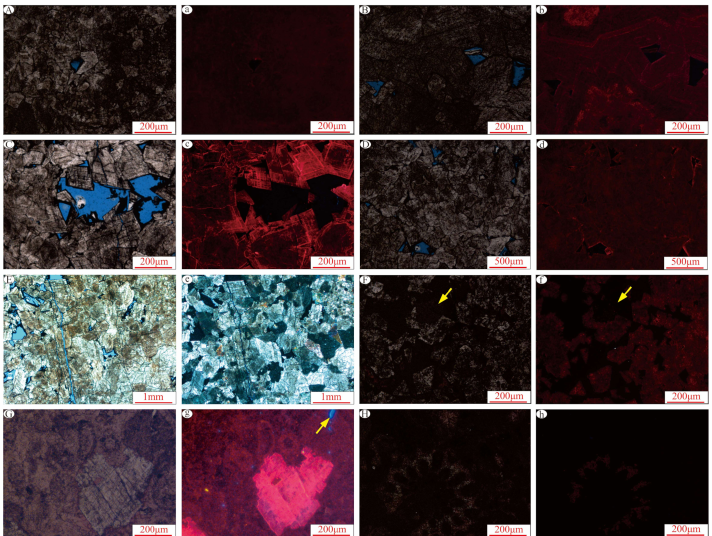
Figure 2. The thin-section image and CL color of the carbonate rocks from the Qixia Formation. ( A ) MX42, 4659.68 m, fine-crystalline dolostone(-), ( a ) MX42, 4659.68 m, fine-crystalline dolostone, the color is dark red under cathode luminescence; ( B ) MX42, 4655.62 m, meso-coarse crystalline